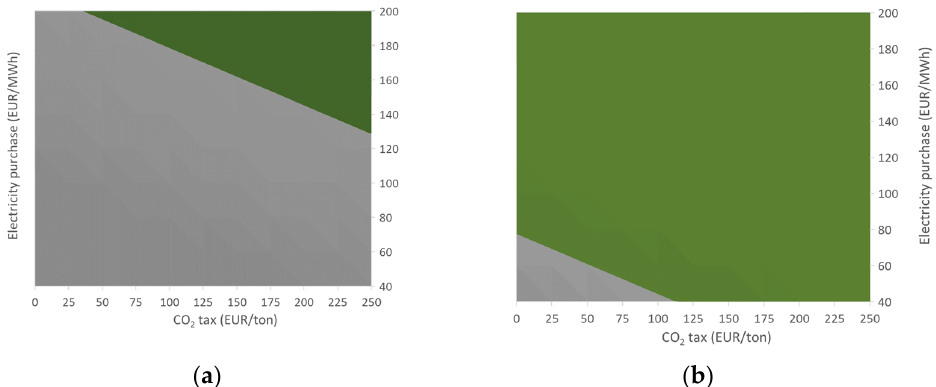
Figure 10. Dependence of the NPV > 0 (green) versus electricity purchase price at discharge and CO 2 tax. Scenarios: ( a ) average cost, ( b ) low cost.